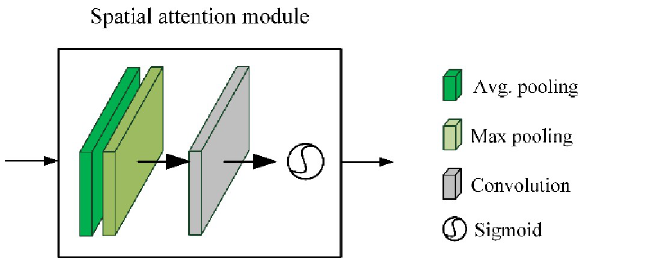
Fig 8. The structure of spatial attention module.